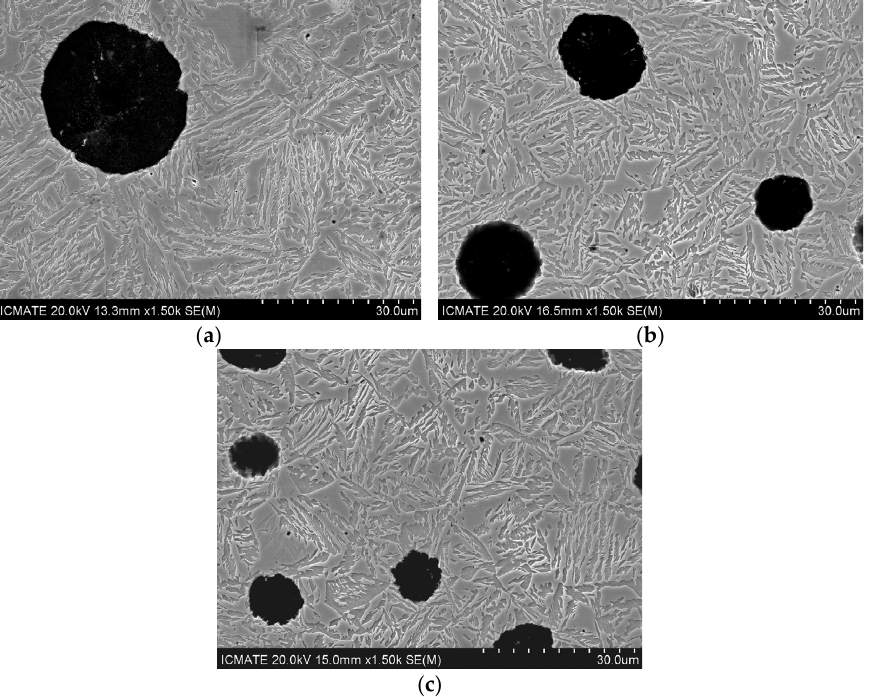
Figure 5. Selected SEM micrographs through Secondary Electron Imaging (SEI) of ADIs castings with 1.5 wt% of Ni after austempering at 380 °C for 1 h: ( a ) 25 mm wall thickness; ( b ) 5 mm wall thickness and ( c ) 3 mm wall thickness casting.